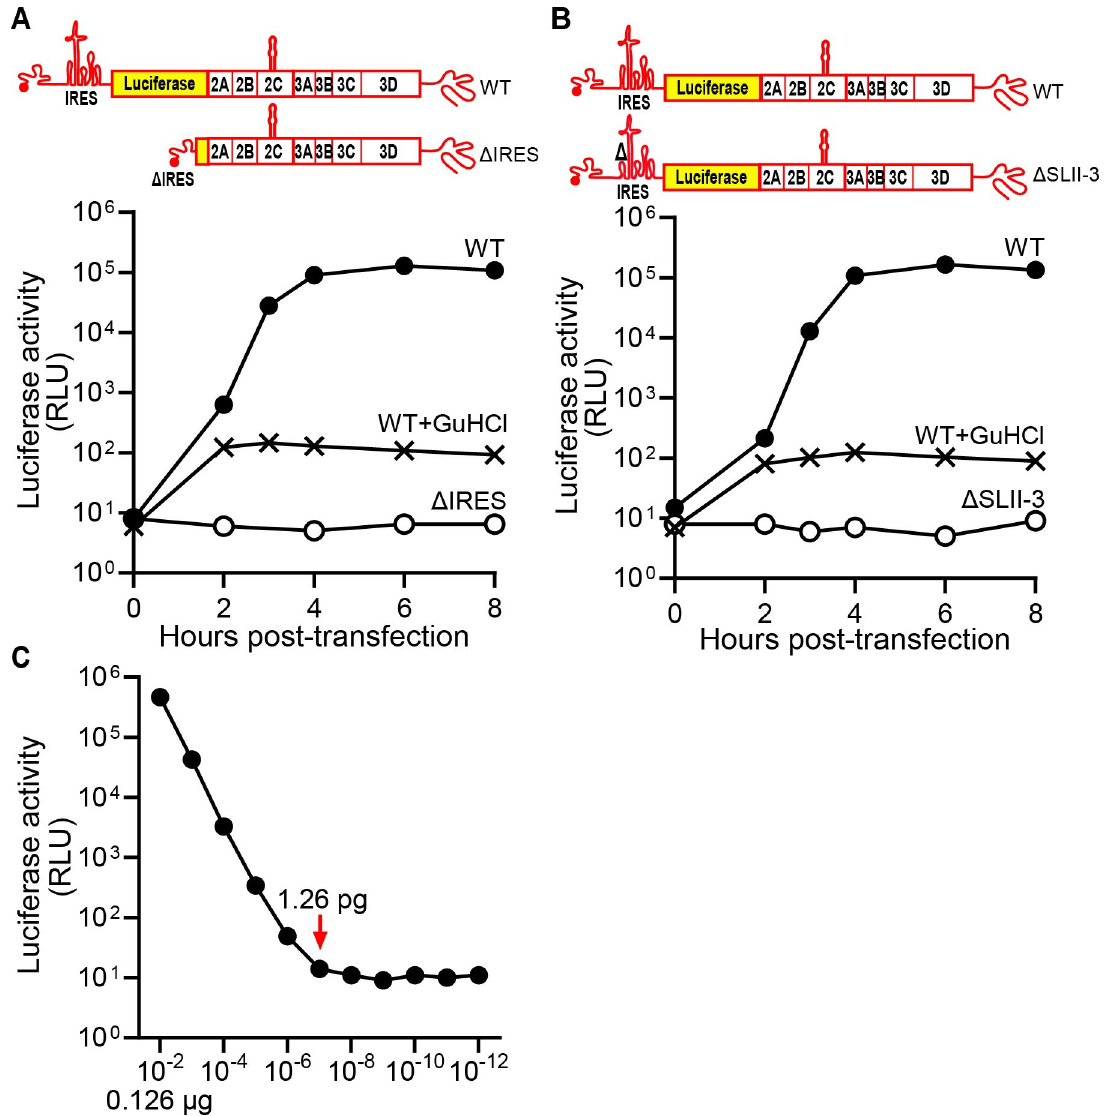
Fig 6. IRES-independent translation may initiate downstream of luciferase-coding sequence within the nonstructural protein- coding sequence. (A, B) Subgenomic replicon luciferase assay comparing the depicted RNAs: WT vs. Δ IRES(panel A )and WT vs. Δ SLII-3 RNAs (panel B ).As a control, the WT RNA was transfected in the presence of GuHCl. Luciferase activity is reported in RLUs as a function of time posttransfection. Luciferase units for Δ IRESand Δ SLII-3were not detected above 10 1 . Numerical data provided as Supporting information (S1Data). (C) Luciferase activity observed for a serial dilution of purified recombinant luciferase enzyme. The initial amount of luciferase in the reaction was 12.6 μ g.The limit of detection was reached at a 1 × 10 7 fold dilution (1.26 pg luciferase), indicated by the red arrow.This corresponds to 1.2 × 10 7 molecules of luciferaseand 1,200 molecules of luciferase per cell from RNAs containing either a deleted IRES or Δ SLII-3.Numerical data provided as Supporting information (S1Data).GuHCl, guanidine hydrochloride; IRES, internal ribosome entry site; RLU, relative light unit,